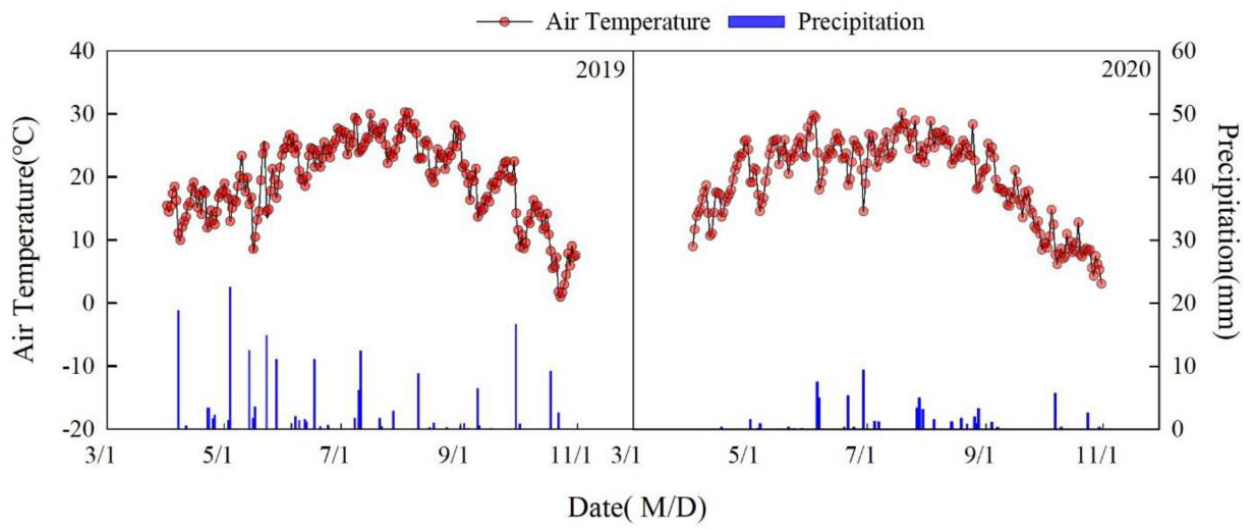
Figure 2. Average air temperature and precipitation in 2019 and 2020 growing